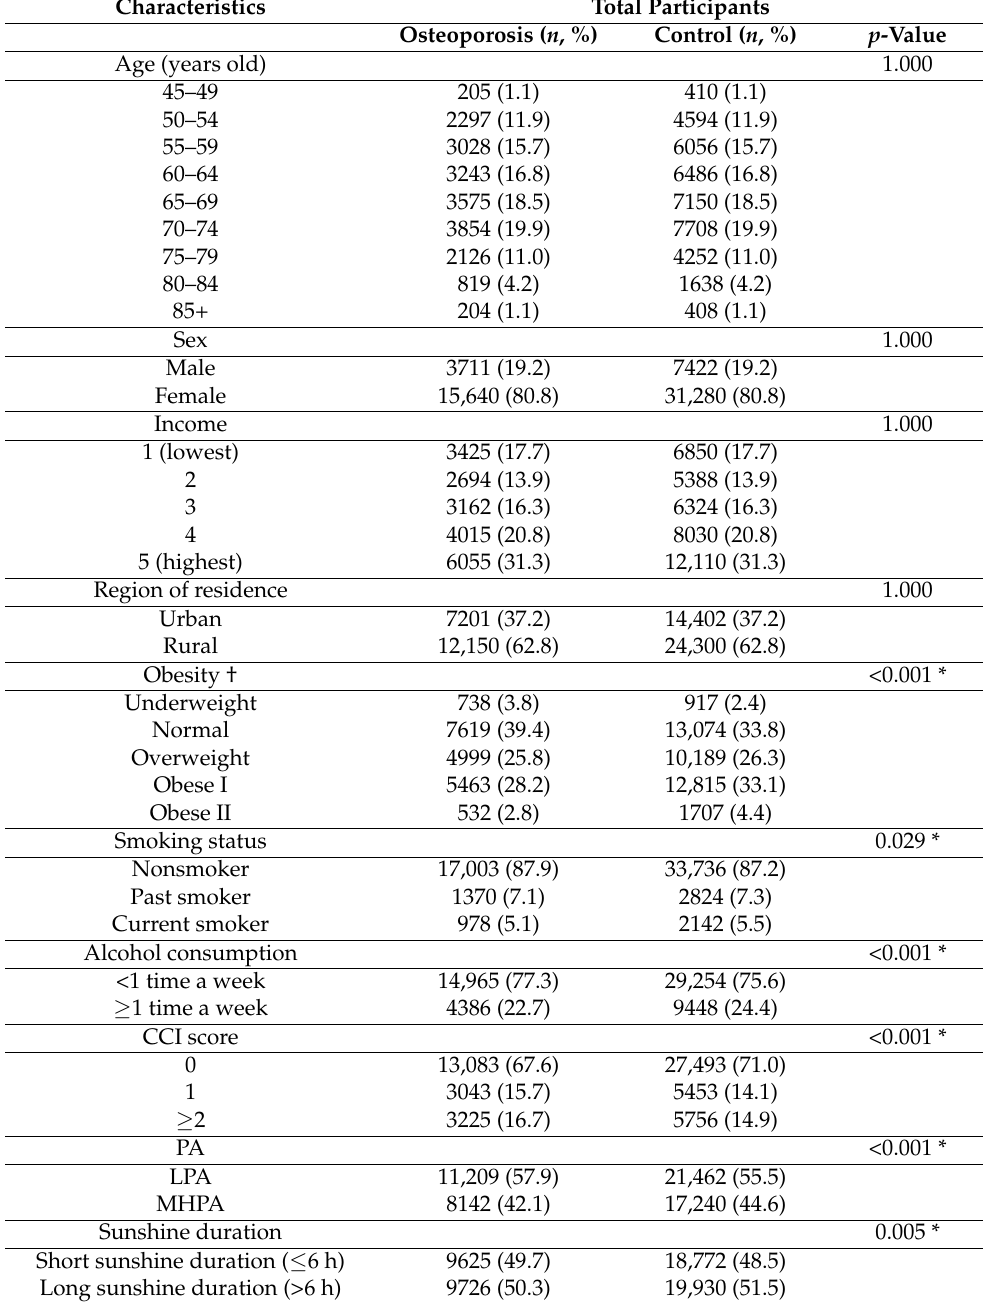
Table 1. General Characteristics of